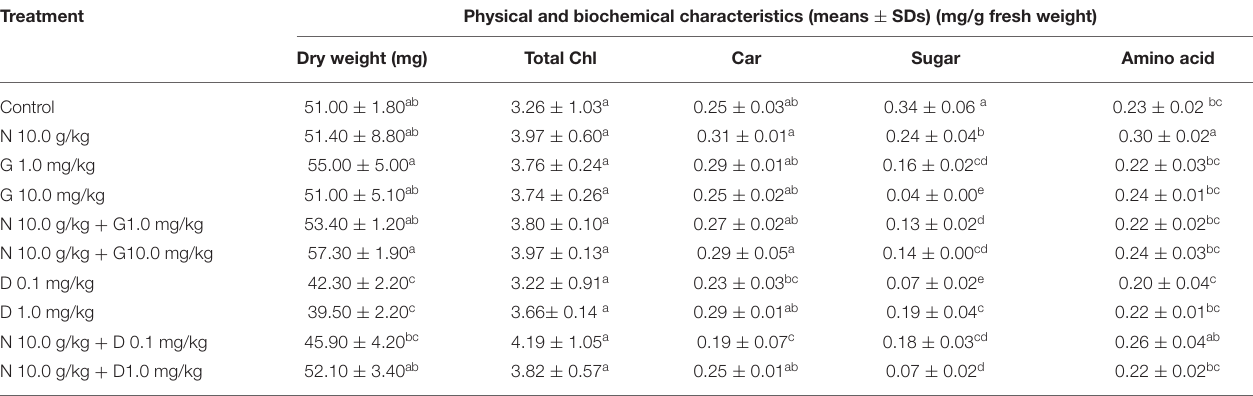
TABLE 5 | Effects of glyphosate, 2,4-D herbicides and Nostoc sp. N1 on the physical and biochemical characteristics of 21-day-old rice seedlings.